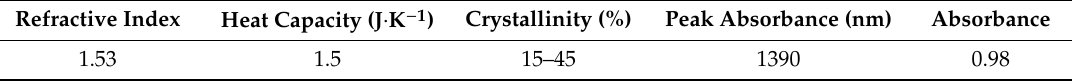
Table 3. Optical properties of Polyamide 6—natural version